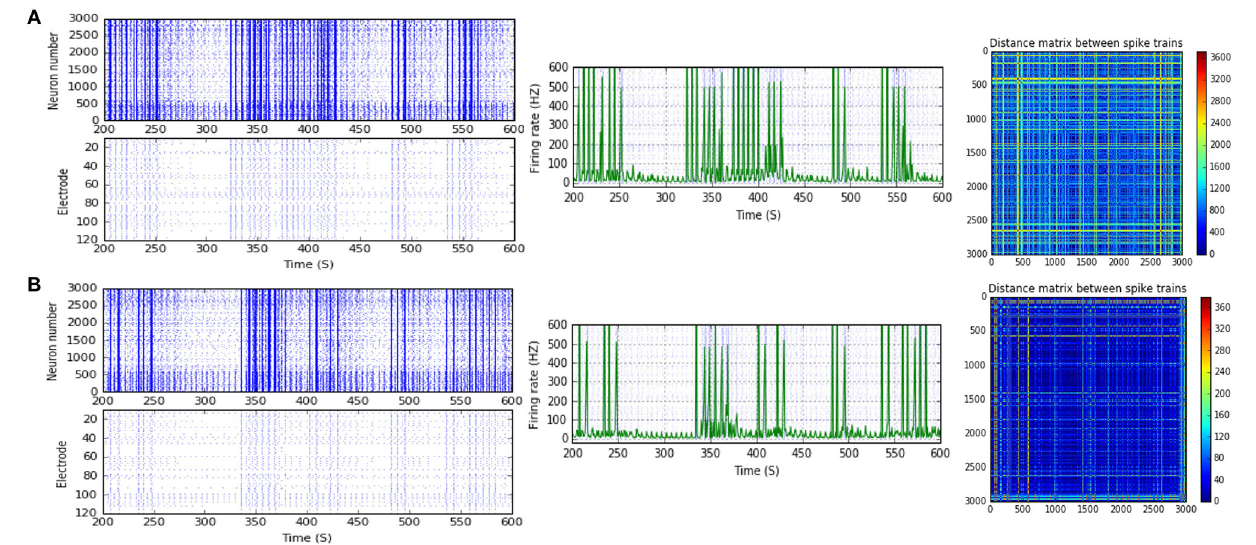
FIGURE 9 | Selected elicited firing response activity in the immature network scenario (B-2) before and after implementing STF2 (when IF gamma). (A) refers to the condition without implementing dynamical synapses (control) while (B) refers to that after implementing facilitating synapses (STF2). The first two figures of each panel refer to monitoring the pattern of firing activity in time windows from 200 to 600 seconds(s). Heat maps of each panel represent modulation changes in spike distance matrix of the network scenario (B-2) before and after implementing STF2. The simulation time for heat maps of the spike distance is equal to